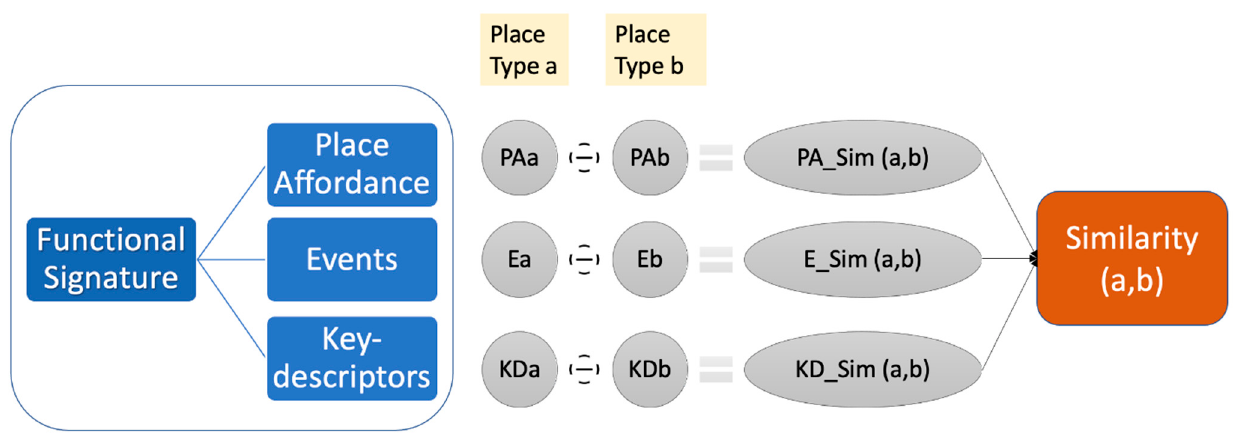
Figure 1. The conceptual framework for assessing similarity between two place